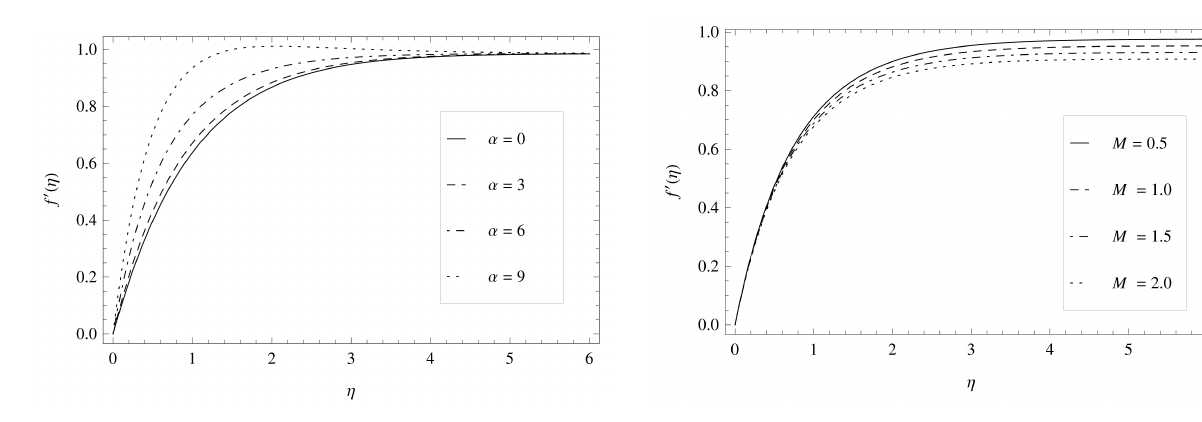
Fig. 4: The influence of a parameter λ on f (cid:48) ( η ) for α = 9, We = 0.5,